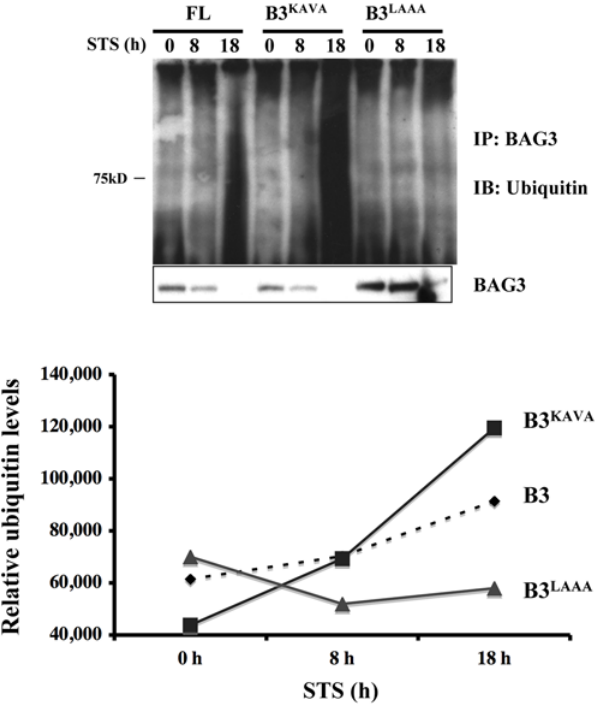
Figure 5. BAG3 degradation requires sequential caspase cleavage followed by ubiquitination. Mutation of the LEAD caspase cleavage site precludes ubiquitination and loss. B3, BAG3 KAVA and BAG3 LAAA cells were exposed to 2 m M STS as indicated. Iodoacetamide-treated lysates were immunoprecipitated with anti- BAG3 and immunoblots probed for ubiquitin. The partial protection of BAG3 KAVA results in a greater quantity of polyubiquitinated BAG3. Minimal ubiquitination of BAG3 LAAA is demonstrated, consistent with a requirement for cleavage prior to ubiquitination. Quantity of poly- ubiquitinated BAG3 protein was estimated by